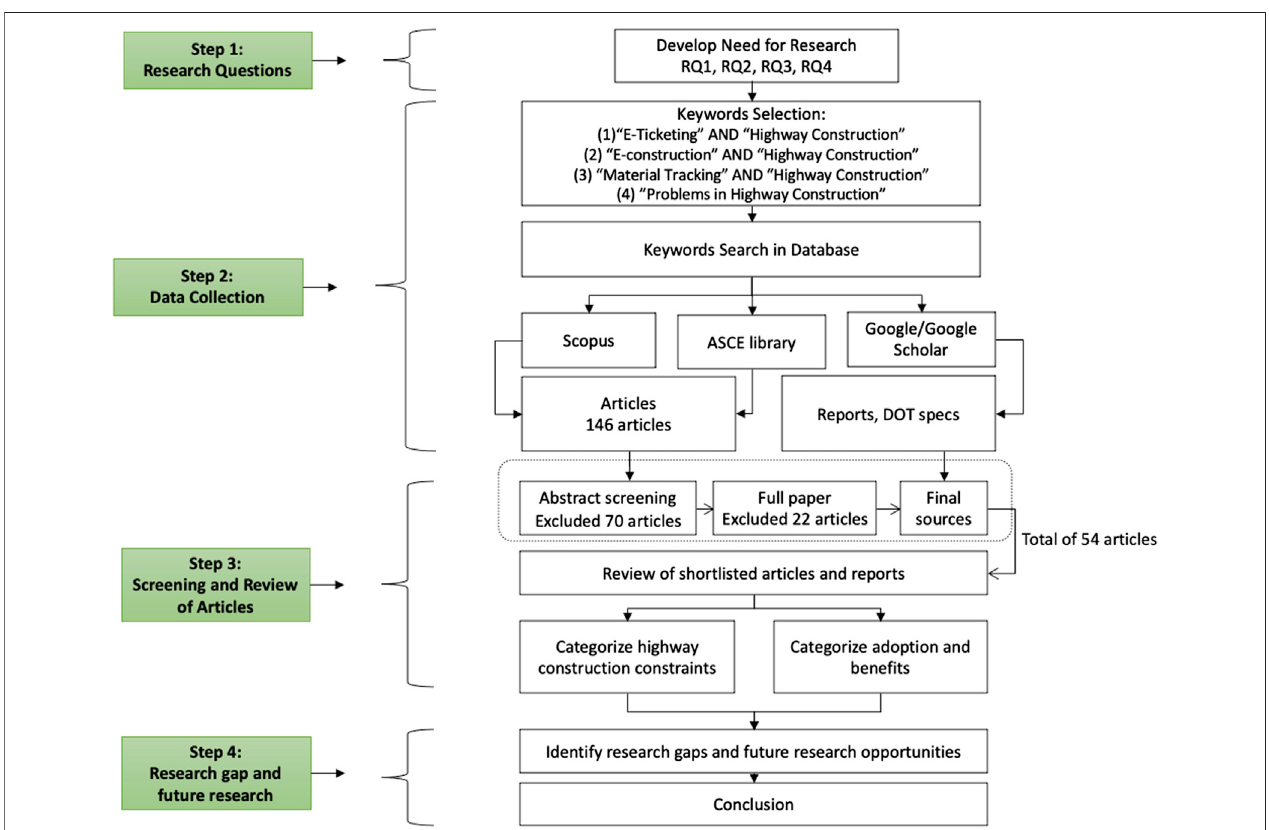
FIGURE 1 | Research